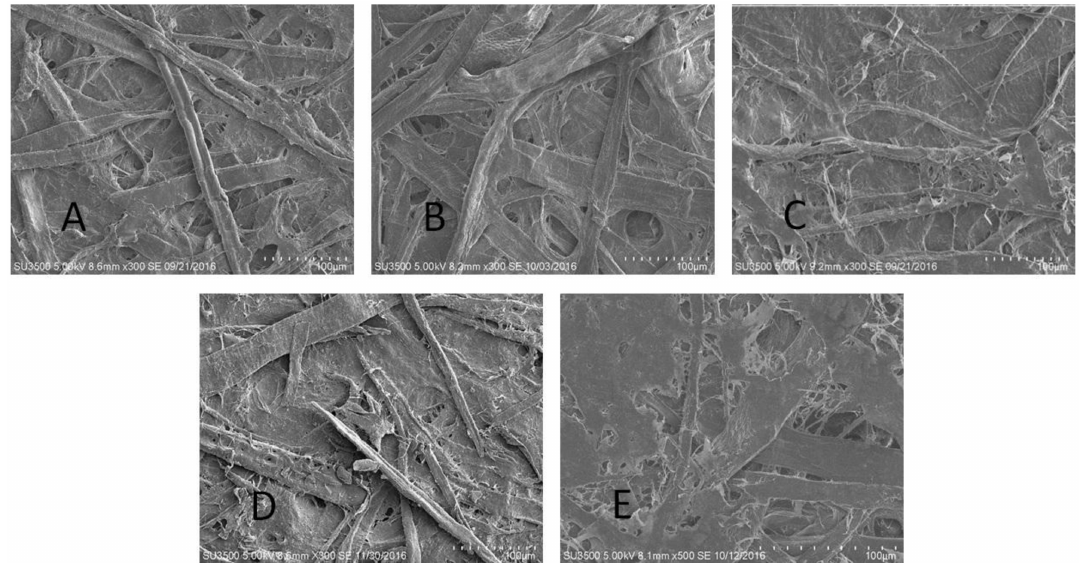
Figure 1. ( A ) SEM (Scanning Electron Microscope)) of the blank handsheet, 300 × magnification; ( B ) SEM of the sample vanillic acid, without CPX (Chitosan), 300 × magnification; ( C ) SEM of the sample 1,2–DHB (Catechol) without CPX, 300 × magnification; ( D ) SEM of the sample gallic acid without CPX, 300 × magnification; ( E ) SEM of the sample gallic acid with CPX, 300 × magnification.